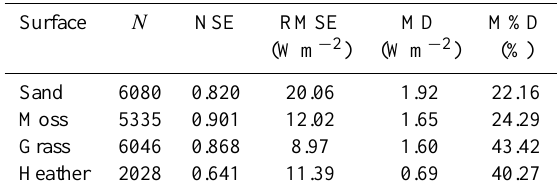
Table 4. Model performance of G simulations.